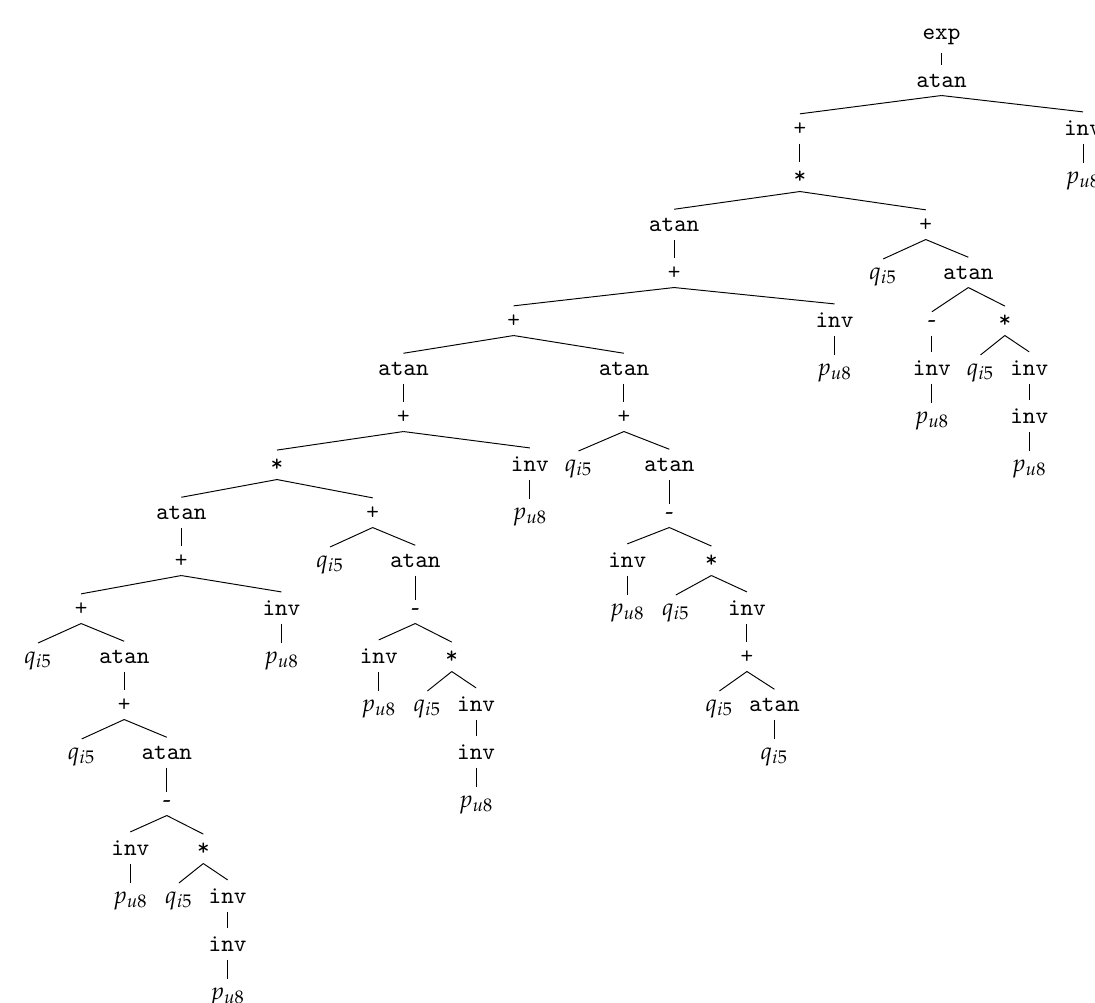
Figure 3. Tree representation of the best individual achieved for the FilmTrust dataset ( EMF-10 ). The correspondence between node symbols and operators are defined in Table 1.